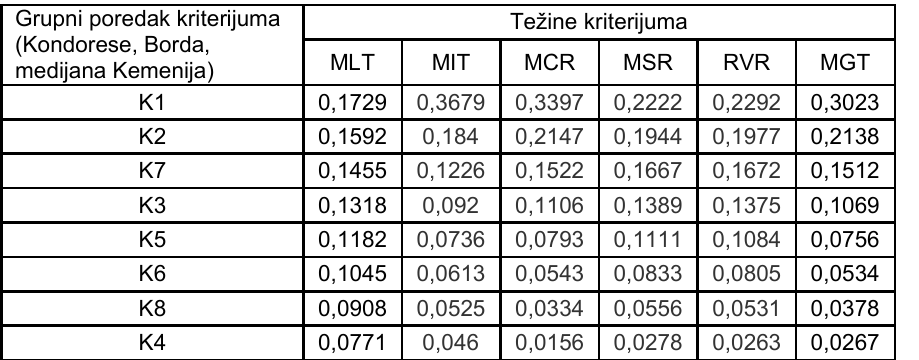
Table 7 – Criteria weights based on the group